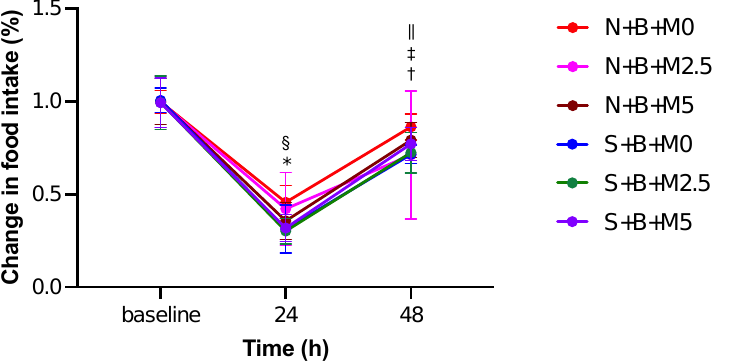
Figure 3. Comparison of post-treatment changes in food intake. Data are presented as mean ± SD. *, value significantly differs ( p < 0.01) between the baseline and 24 h in all groups. †, value significantly differs ( p < 0.01) between 24 h and 48 h in all groups. ‡, value significantly differs ( p < 0.05) between the baseline and 48 h (excluding the N + B + M0, N + B + M2.5, and N + B + M5 groups). §, value significantly differs ( p < 0.05) between the N + B + M0 and S + B + M2.5 groups. ||, value significantly differs ( p < 0.03) between the N + B + M0 and S + B + M0 groups. N + B + M0 group: n = 6; N + B + M2.5 group: n = 6; N + B + M5 group: n = 6; S + B + M0 group: n = 7; S + B + M2.5 group: n = 7; and S + B + M5 group: n = 7.